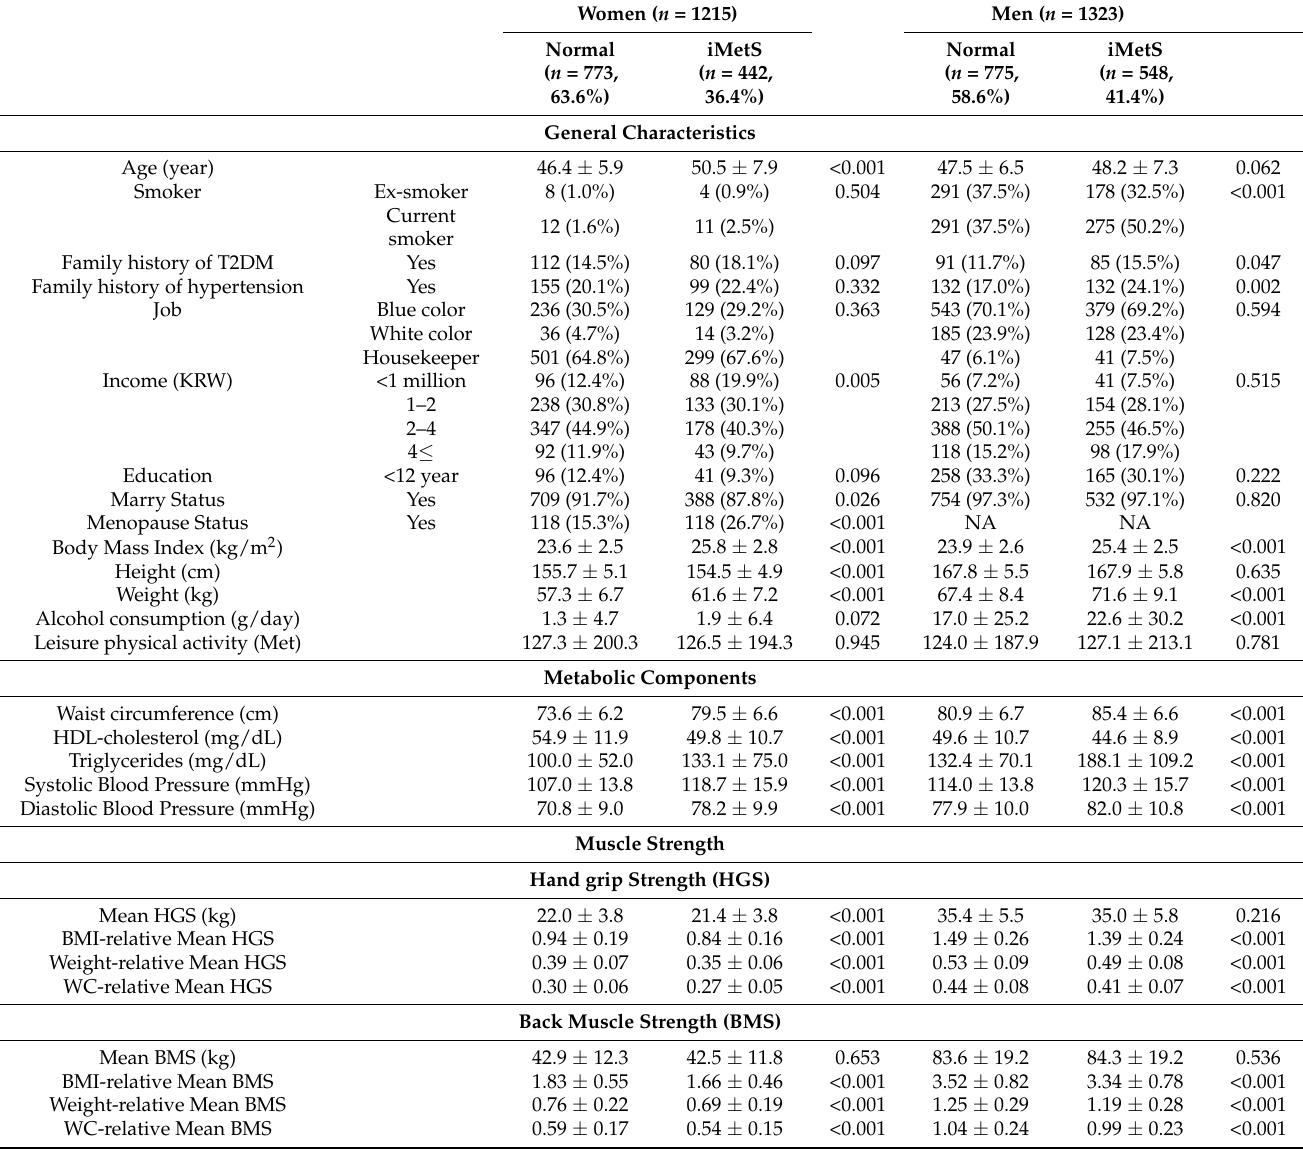
Table 1. Demographic and clinical characteristics in baseline according to non-MetS and incident